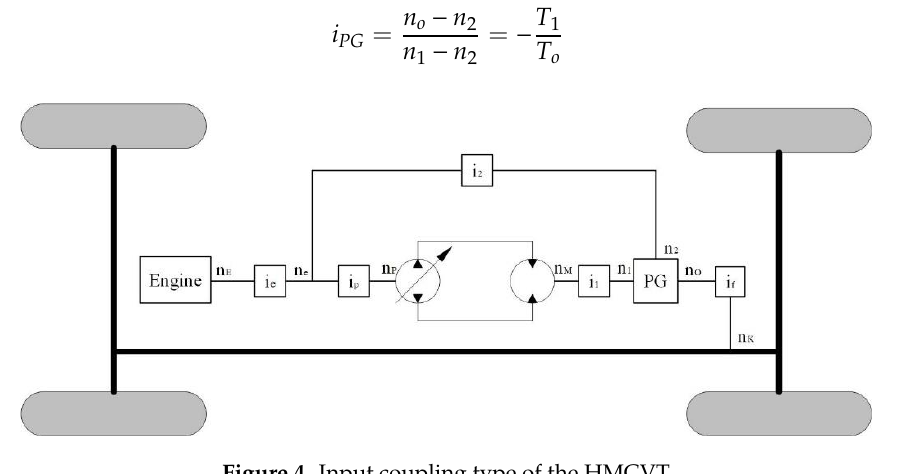
Figure 4. Input coupling type of the HMCVT.